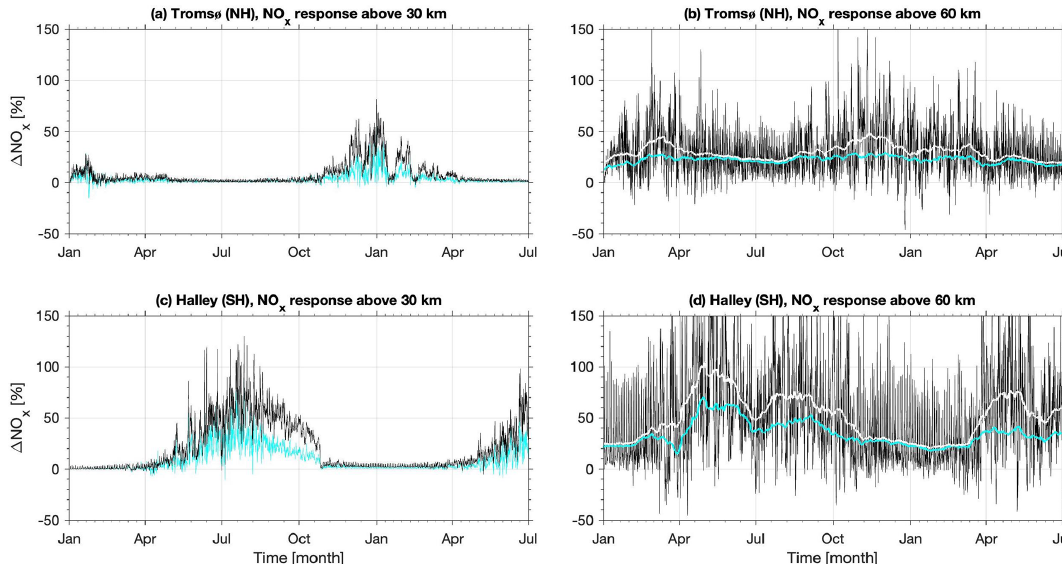
Figure 5. Height-integrated NO x response to PsA EEP at the Tromsø and Halley stations. (black line, all panels) The difference between the full-PsA and no-PsA simulations in 1h resolution. (cyan line, panels a and c ) The difference between the thermo-PsA and no-PsA simulations in 1h resolution. (white line, panels b and d ) The 30d running mean of the black line. (cyan line, panels b and d ) The 30d running mean of the difference between thermo-PsA and no-PsA